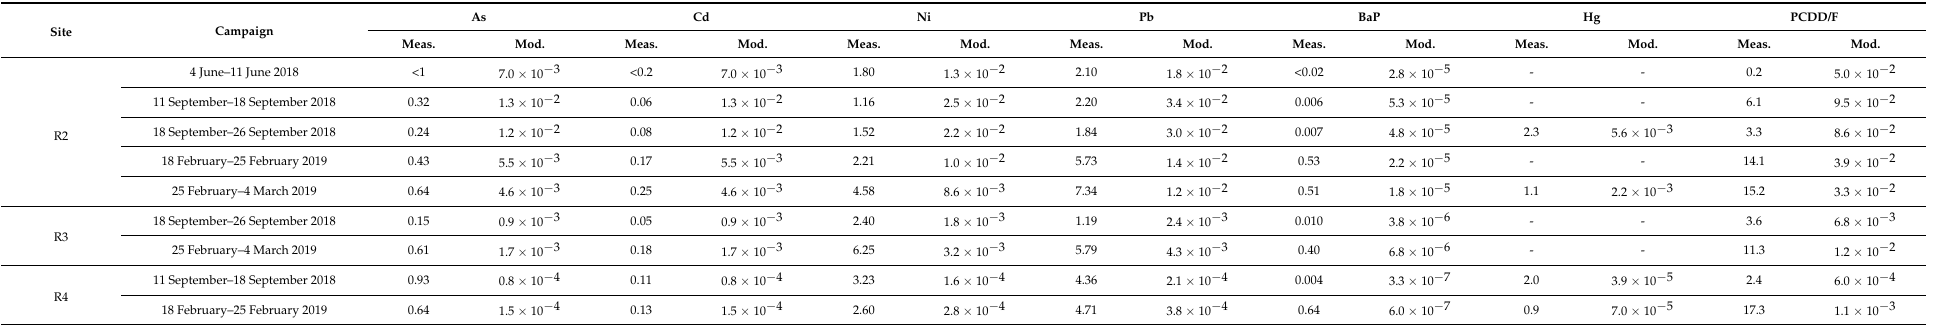
Table 6. Weekly average concentrations measured (Meas.) and modelled (Mod.) during the monitoring campaigns at site R2, R3, and R4 for toxic elements, benzo(a)pyrene and mercury (ng m − 3 ), and for dioxins and furans (PCDD/F, fg ITEQ m − 3 ). As Cd Ni Pb BaP Hg PCDD/F Site Campaign Meas. Mod. Meas. Mod. Meas. Mod. Meas. Mod. Meas.